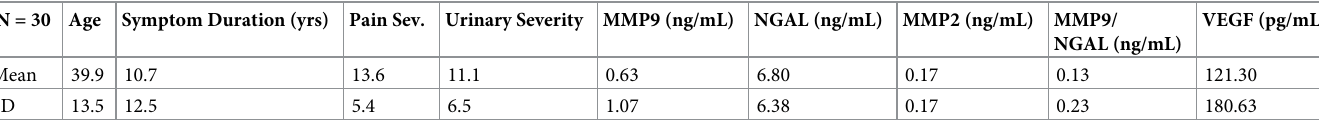
Table 1. UCPPS patient characteristics. Values reported as mean ± standard